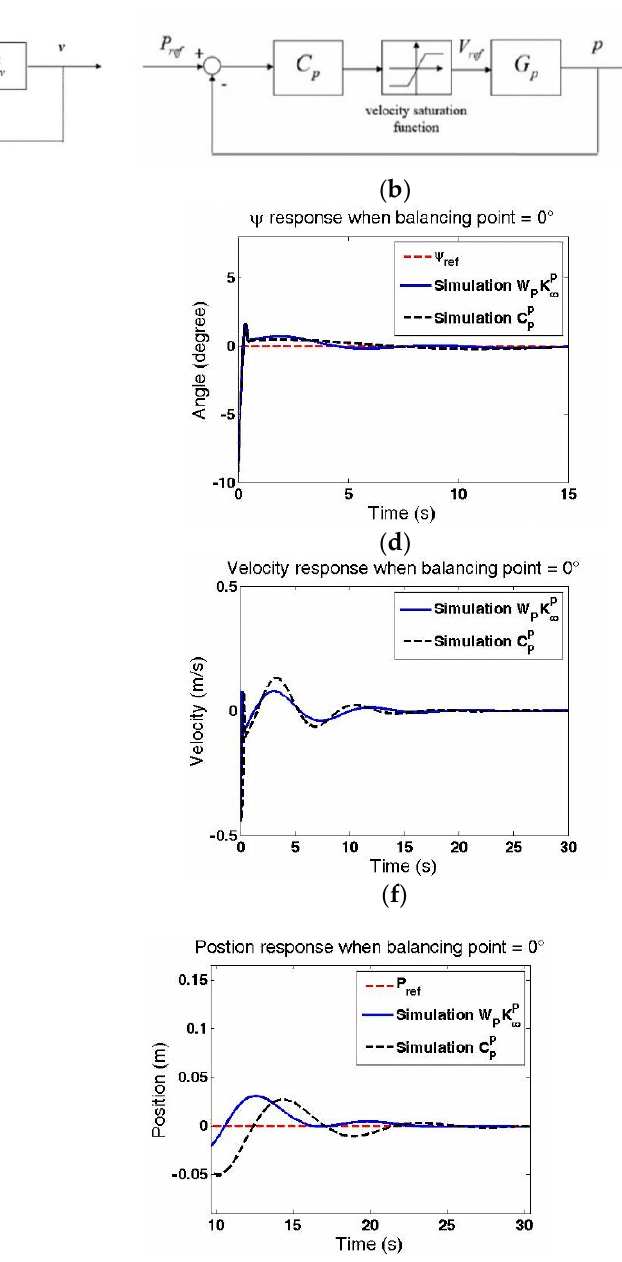
P : ( a ) The position loop control structure; ( b) ref  responses; ( e ) control signal ( ) V adjustment; ( d ) V t ; ( f )  ref